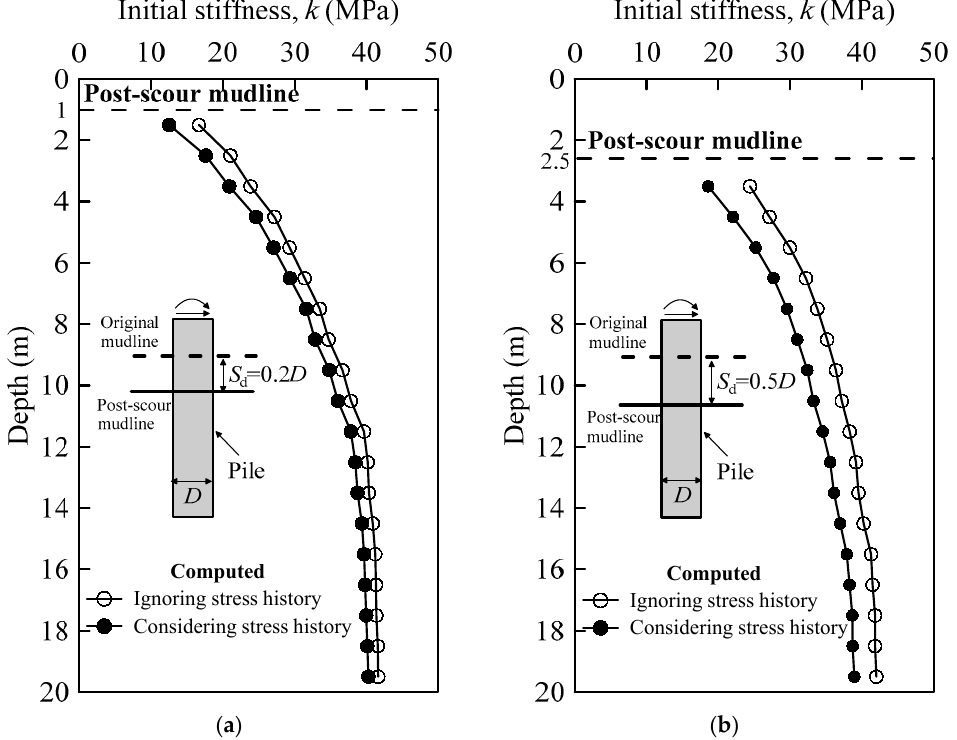
Figure 14. Distributions of the initial stiffness of the p-y curves at scour depth of: ( a ) S d = 0.2 D ; ( b ) S d = 0.5 D .